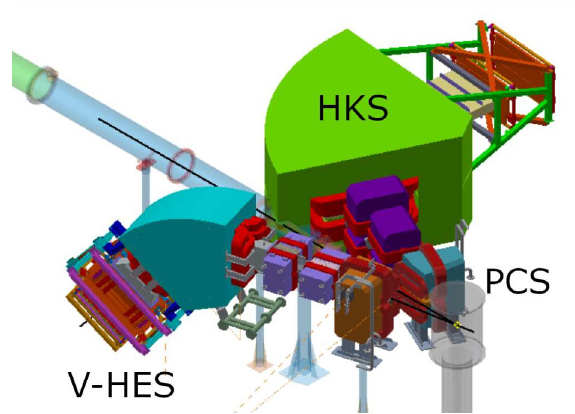
Figure 6. Setup in Hall C. Both HKS and HES were used in previous Hall-C experiments, however, HES will be modi fi ed to be a vertical bending